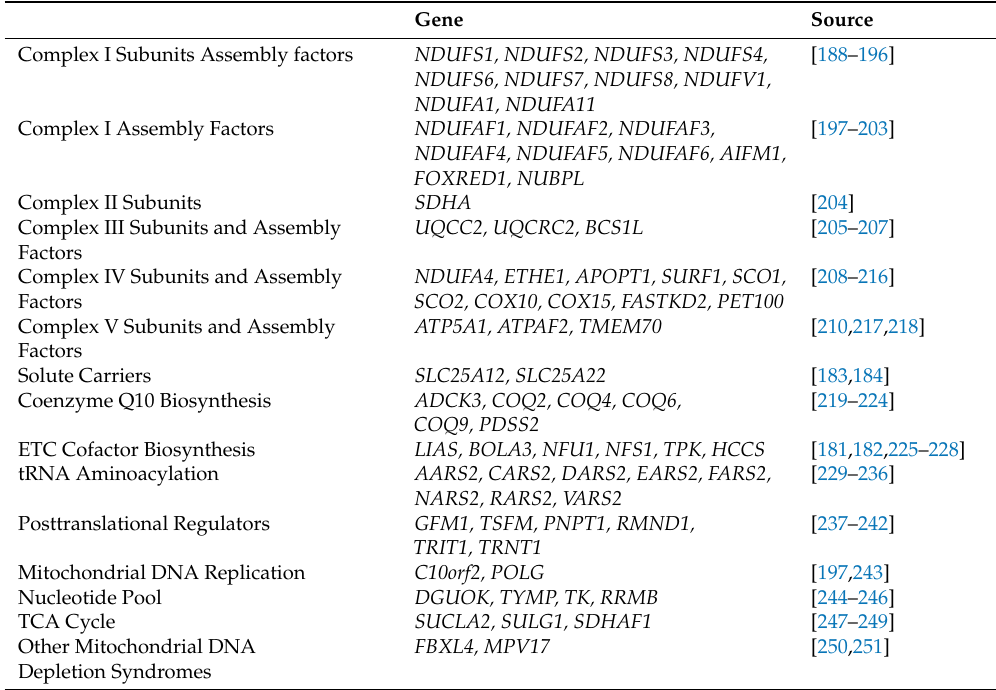
Table 1. Nuclear genes involved in mitochondrial function associated with